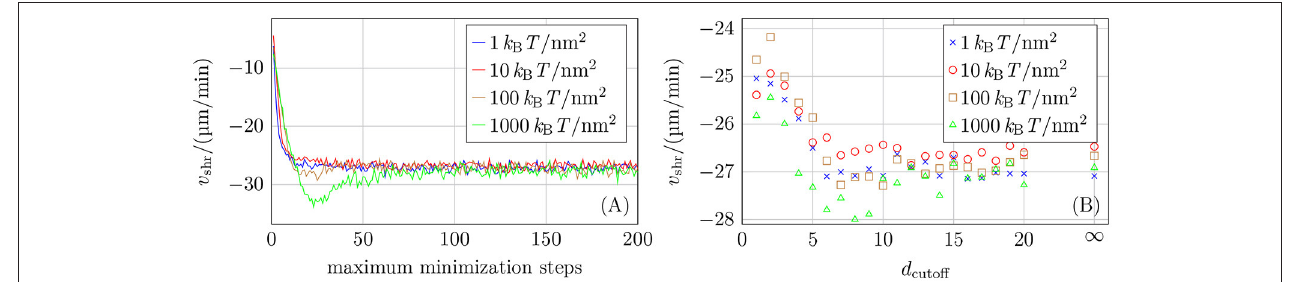
FIGURE 6 | (A) Shrinkage velocity v shr as a function of the maximum number of minimization steps. (B) Shrinkage velocity v shr as a function of the layer cutoff distance d cutoff (where d cutoff = ∞ means that no cutoff was used). Twenty simulations for each parameter set were run for both plots and both used k + = 4 µ M − 1 s − 1 , 1 G 0 ∗ long = − 9.3 k B T , c tub = 10 µ M, N GDP = 20, and different values of k lat